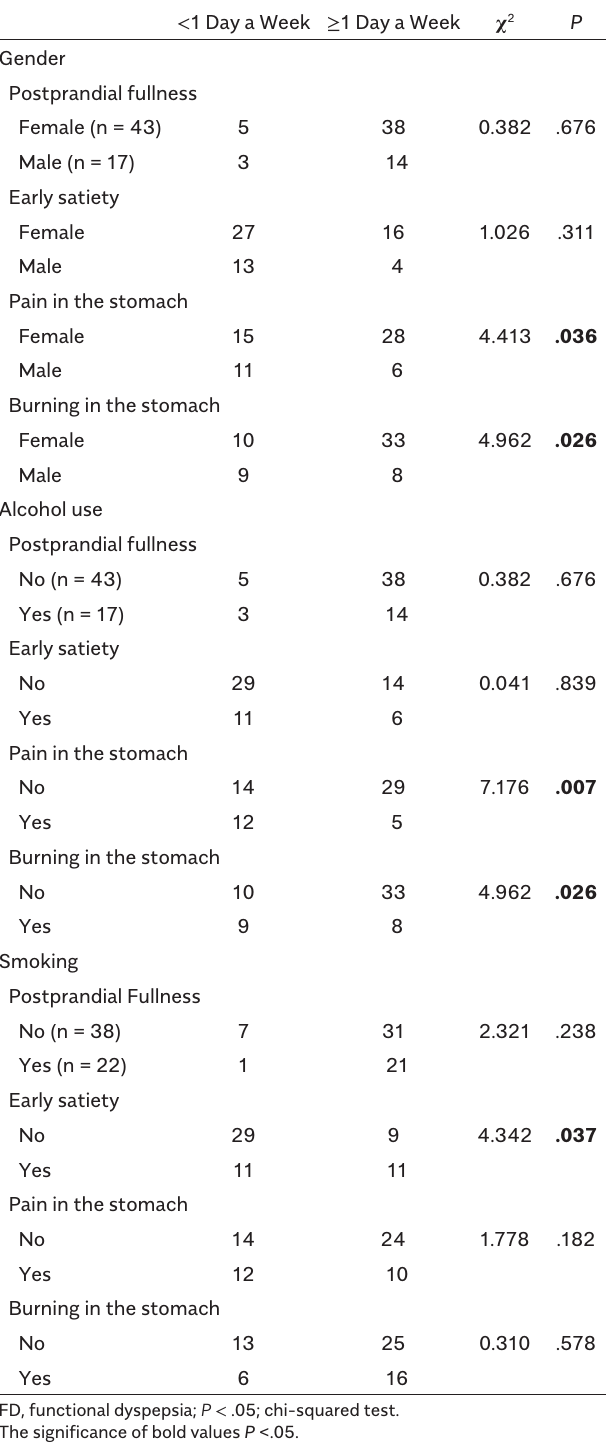
Table 3. Comparison of Gender, Alcohol Use, and Smoking According to FD